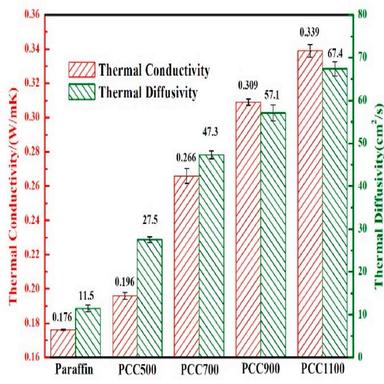
Thermal conductivity and thermal diffusivity of paraffin and PCCs at 25 ◦C.